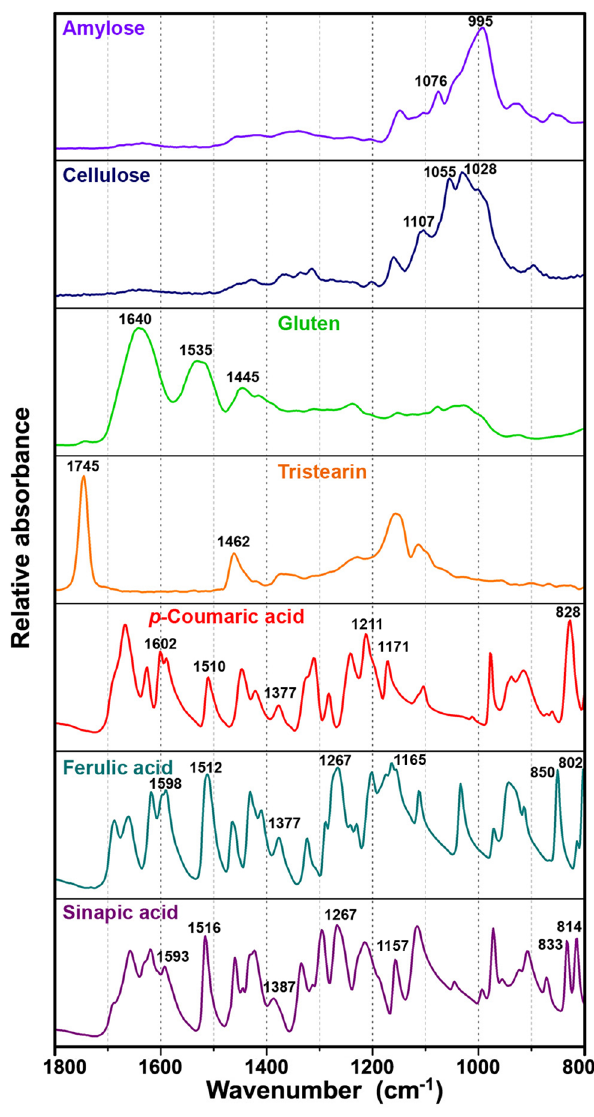
Fig 3. FTIR spectra of biochemicals. carbohydrates (amylose and cellulose), protein (gluten), lipid (tristearin) and phenylpropanoids ( p -coumaric, ferulic and sinapic acids); for better viewing the spectra are